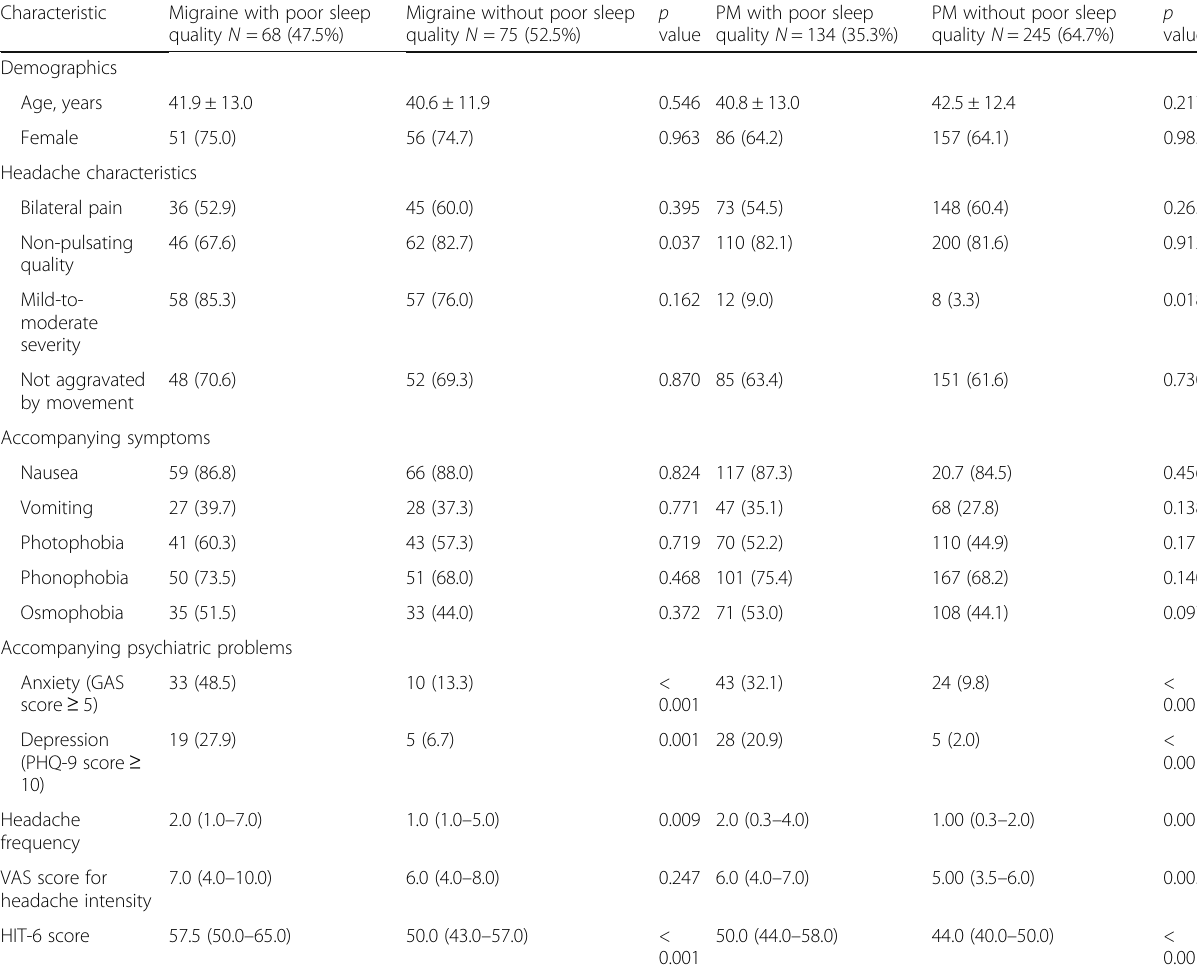
Table 3 Demographics and clinical presentations of participants with migraine and probable migraine stratified according to the presence of poor sleep quality